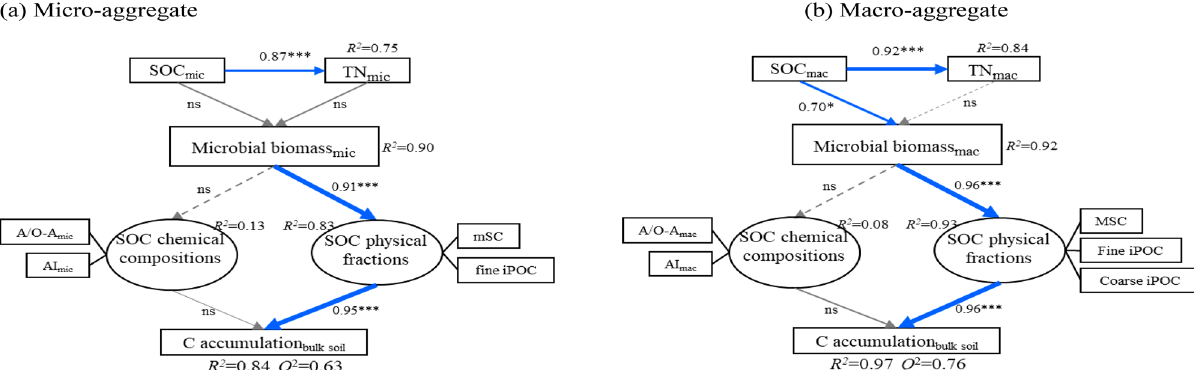
Figure 4. Partial least square structural equation model (PLS-SEM) showing the relationships among soil chemical properties, soil organic C chemical composition and organic C physical components in micro- aggregates ( a ), macro-aggregates ( b ). The overall coefficient of determination ( R 2 ), the effect size ( f 2 ), and the significance of the weights and loadings of manifest variables were used to assess the structural model. Solid lines and dashed lines indicate positive and negative correlations, respectively. The arrow width is proportional to the strength of the path coefficients. ns indicates nonsignificant relationships, while ** and *** indicate significance at p < 0.01 and 0.001, respectively. SOC soil organic C, TN total nitrogen, MBC microbial biomass carbon, mSC mineral-incorporated organic carbon in micro-aggregates, fine iPOC fine intra-particulate organic carbon in micro-aggregates, MSC mineral-incorporated organic carbon in macro-aggregates, Fine/coarse iPOC fine/coarse intra-particulate organic carbon in macro-aggregates. The subscript letters mic and mac represented soil properties of microaggregates and macroaggregates,